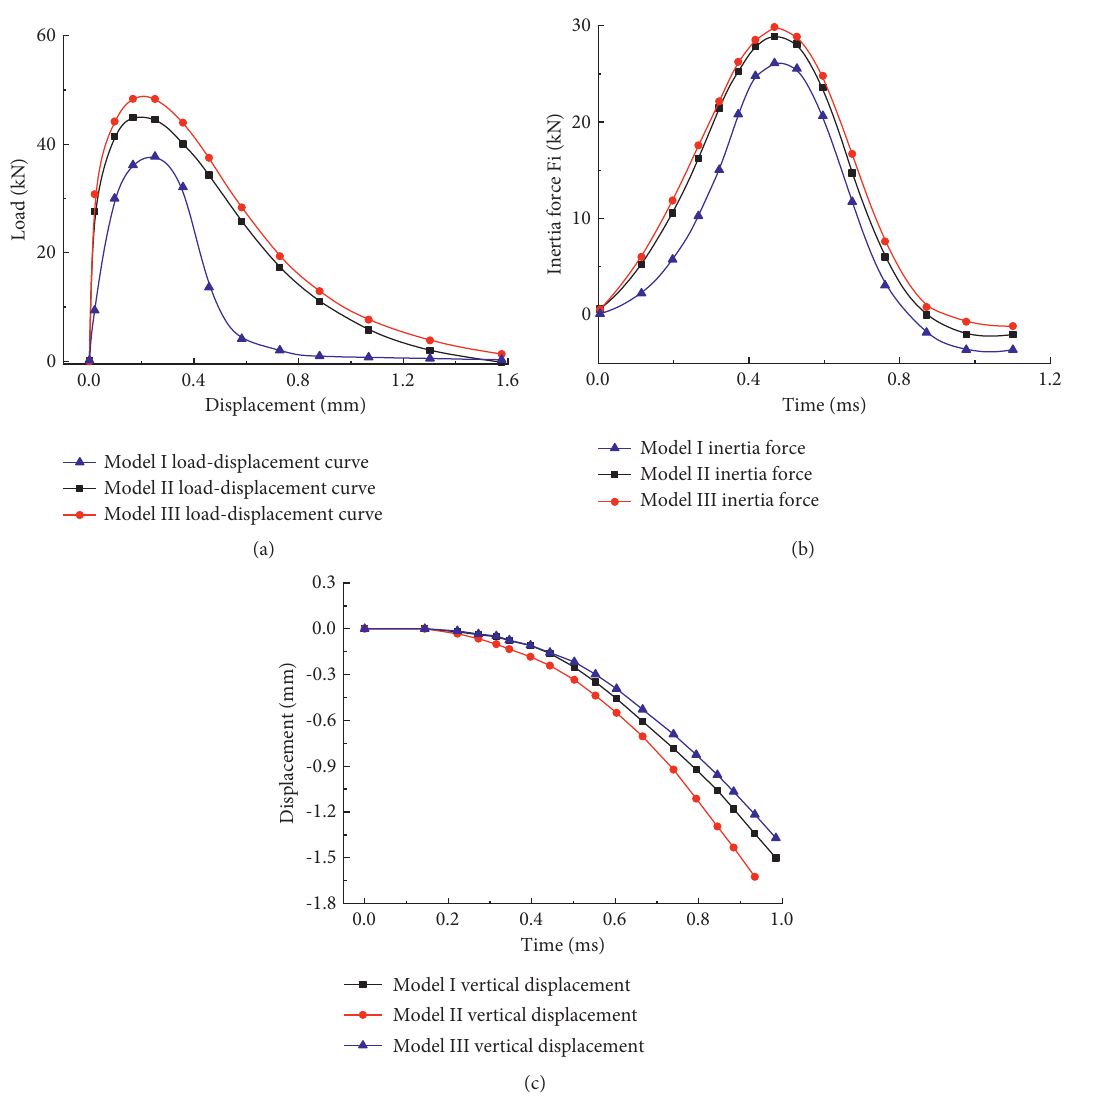
Figure 13: The results of the numerical model under dynamic load. (a) Load-displacement curve. (b) Model inertia force curve. (c) Vertical displacement curve. Table 3: Comparison of calculation methods for tensile strength of numerical models.